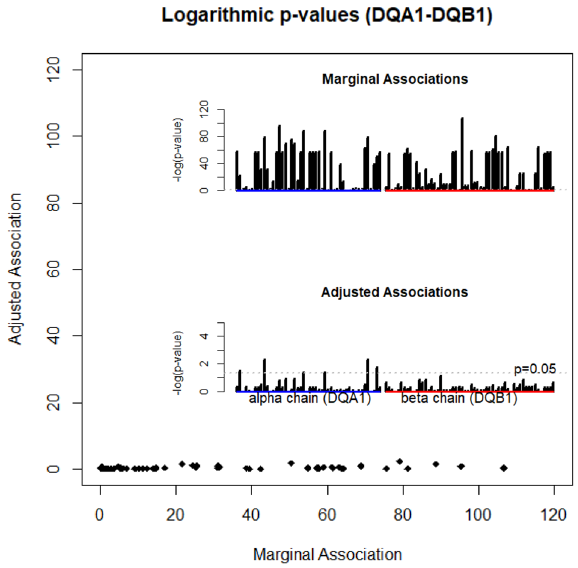
Figure 2. Logarithmic p-values computed for association of type 1 diabetes with the individual residue, with (y-axis) and without (x-axis) adjusting for DQA1-DQB1 motifs.